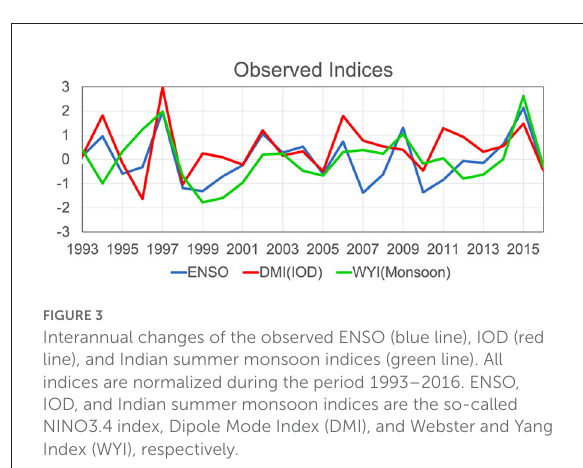
FIGURE3 Interannual changes of the observed ENSO (blue line), IOD (red line), and Indian summer monsoon indices (green line). All indices are normalized during the period 1993–2016. ENSO, IOD, and Indian summer monsoon indices are the